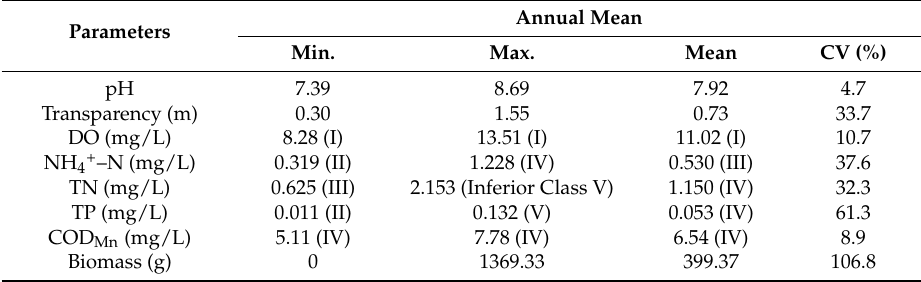
Table 1. Summary statistics of measured variables and water quality class categories for Honghu